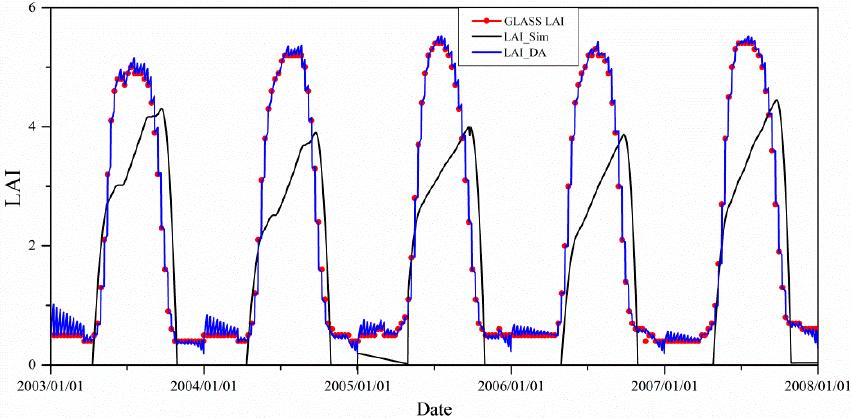
Figure 5. Comparison of simulated LAI and GLASS LAI.